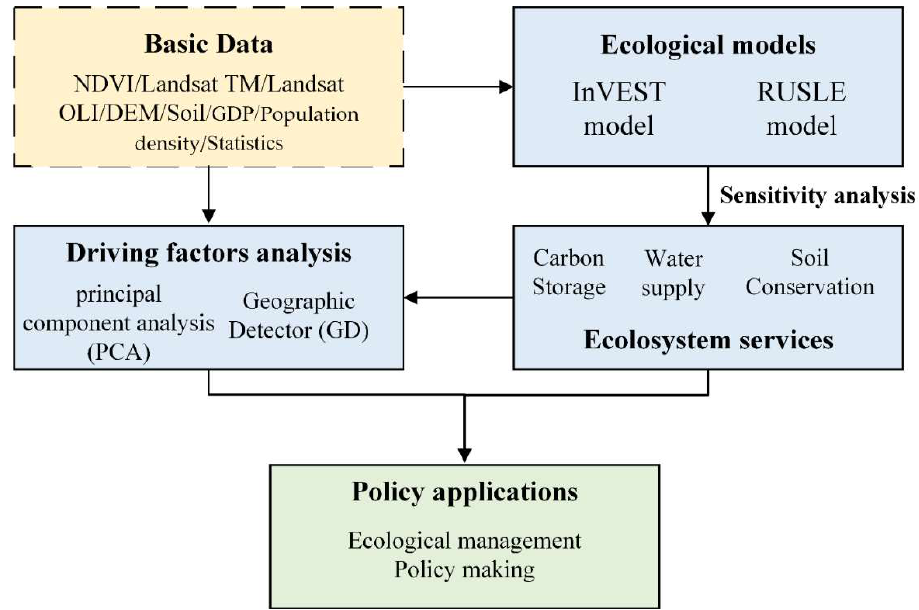
Figure 2. Structure of the method used in this research.